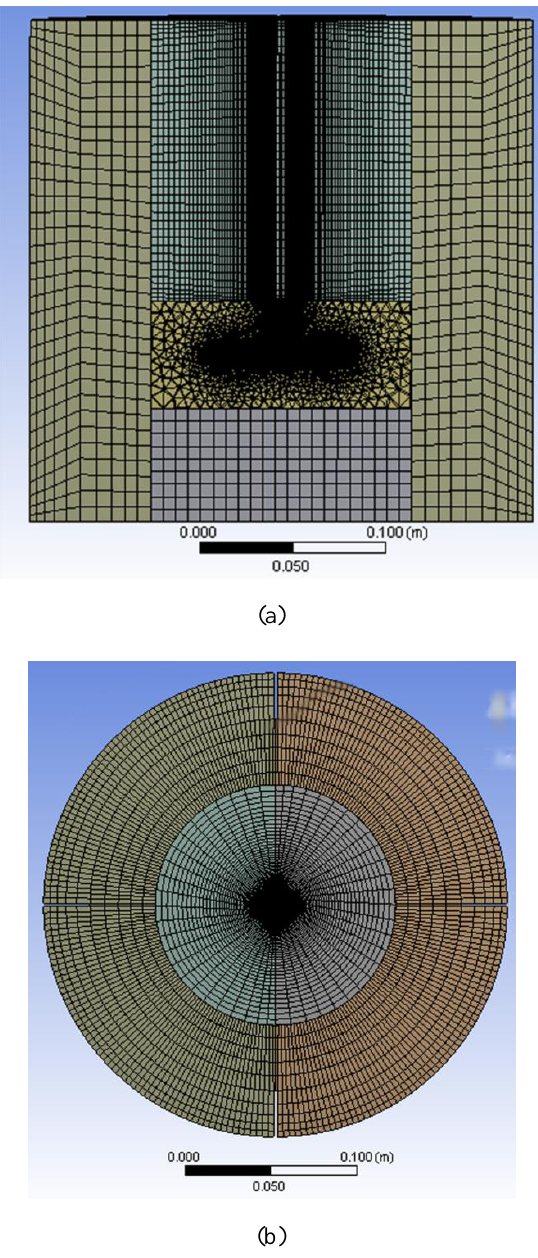
Figure 2. (a) Sectional elevation (b) Plan of meshed